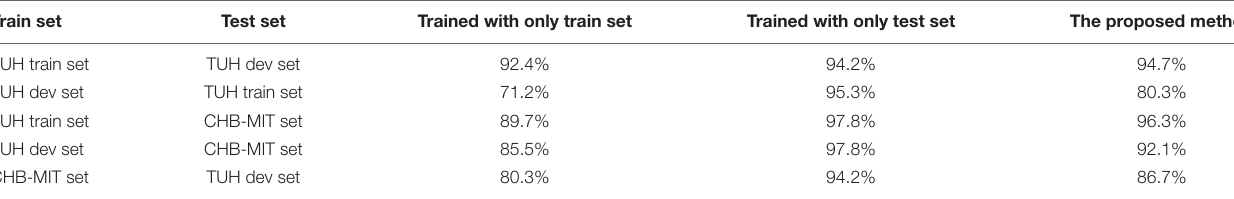
Train set Test set Trained with only train set Trained with only test